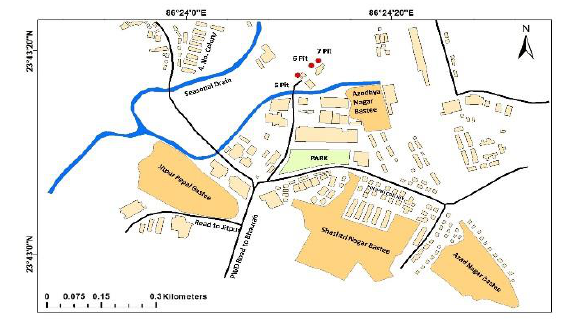
Figure 1. Surface plan map derived from TATA colliery